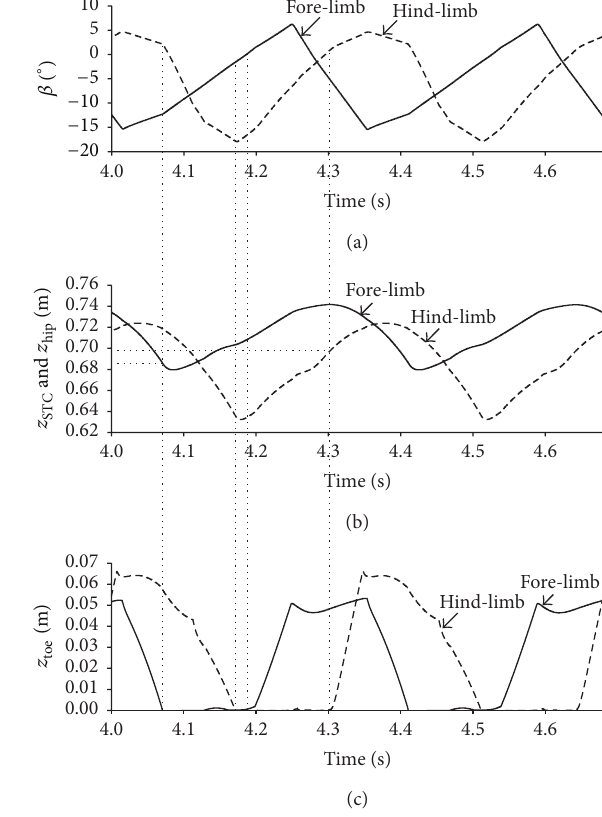
Figure 6: Sequences of the bounding